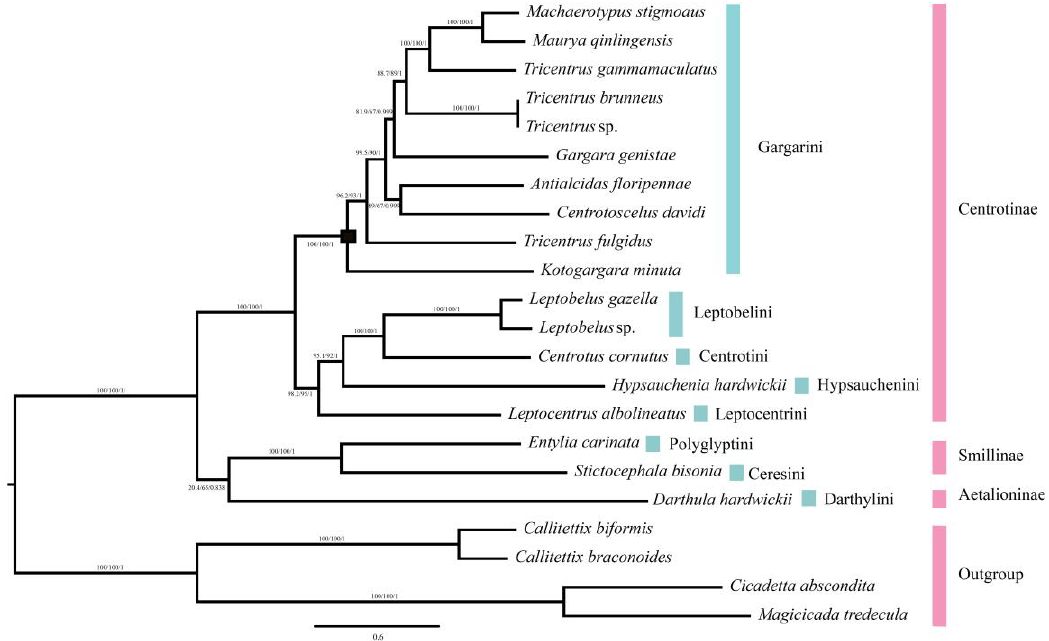
Figure 5. Phylogenetic trees of treehoppers were inferred using MrBayes (Bayesian inference) and maximum likelihood (ML) analysis based on the nucleotide sequences of the 13 protein-coding genes. Bayesian posterior probabilities (BPPs) and bootstrap percentages (BP) are indicated on branches. The black box indicates the branch of Gargarini tribe.